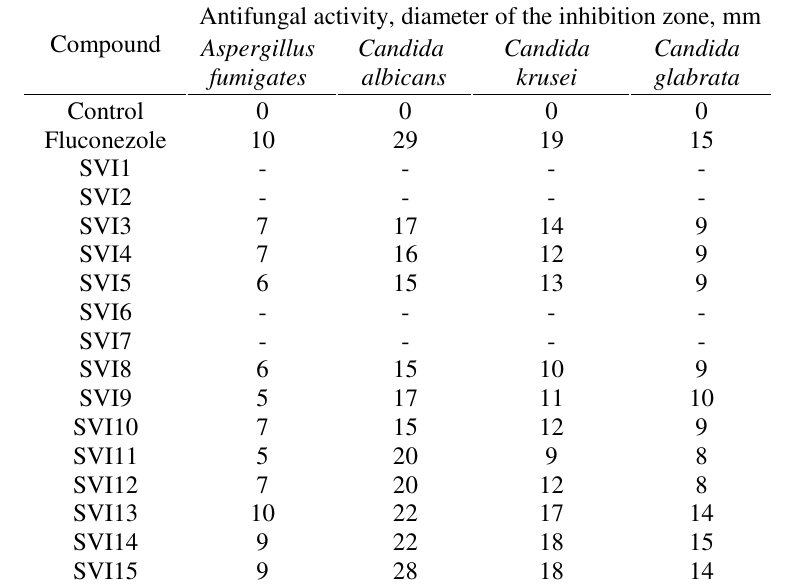
Table 2. Antifungal activity of phenyl pyrazolo benzothiazolo quinoxaline